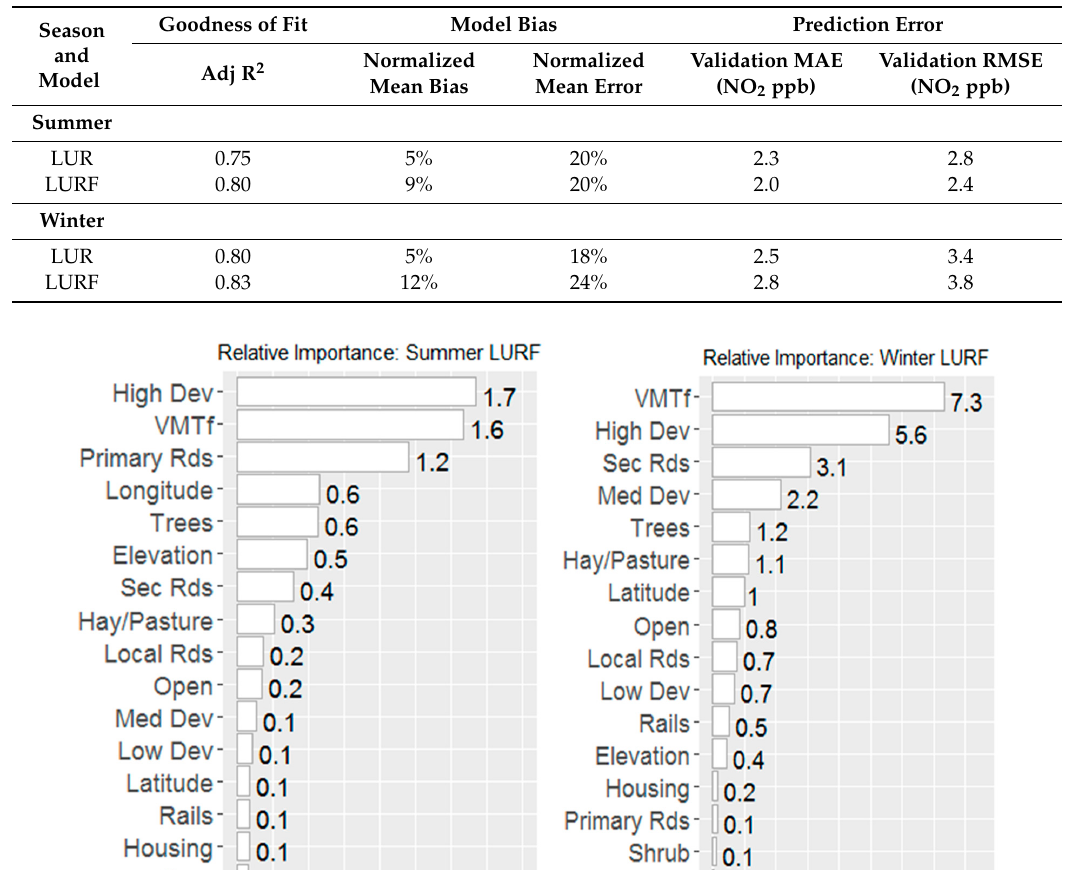
Table 2. Performance metrics for the summer and winter LURF and LUR models using hold out validation.